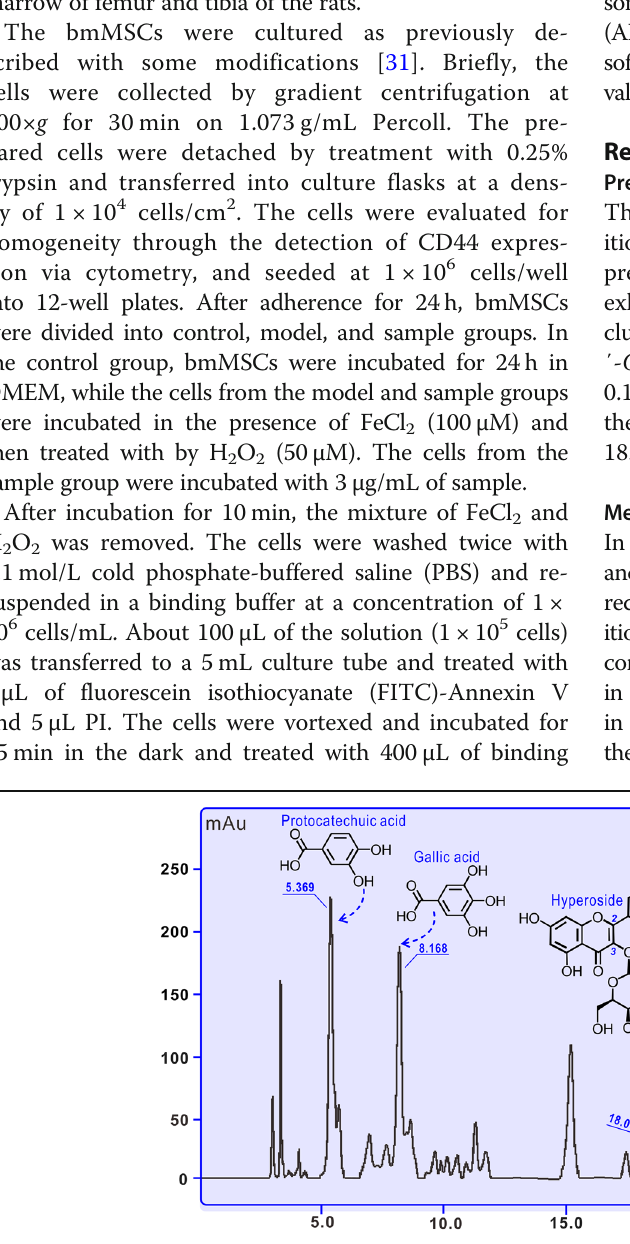
Fig. 3 HPLC analysis of LAEP . LAEP means the lyophilized aqueous extract of P. decorata . The determining wavelength was 280 nm; the longitudinal axis was the strength of absorbance; mAu, milli-absorbance unit; Rt, retention time; Min,